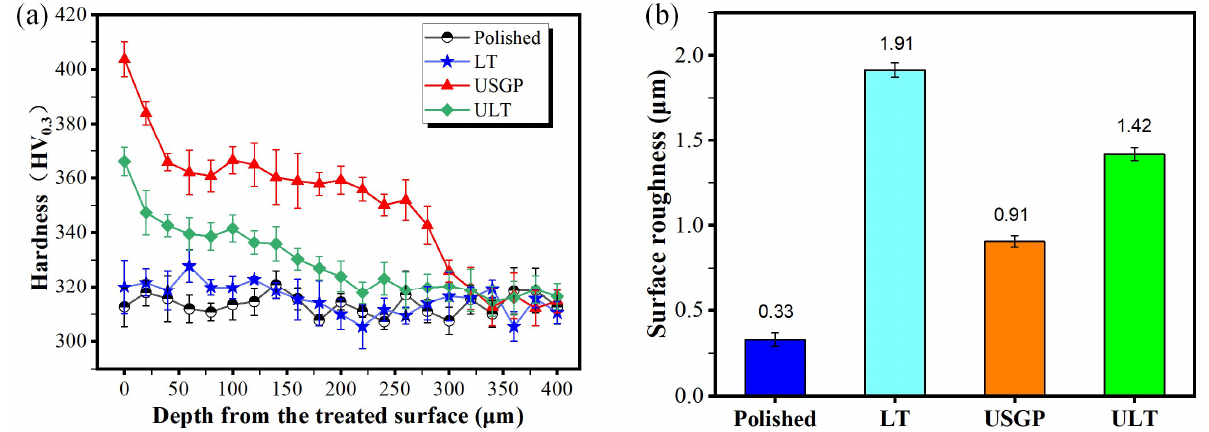
Figure 4. The variation hardness of cross-section ( a ) and the treated surface roughness Ra ( b ) of each sample.